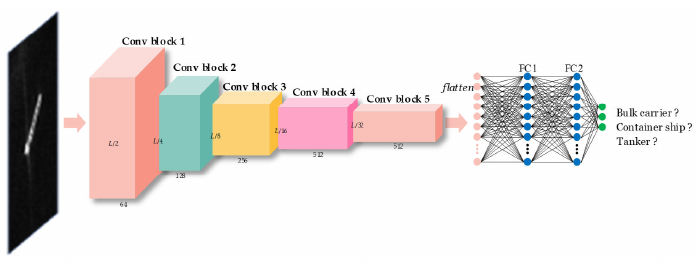
Figure 7. Network architecture of